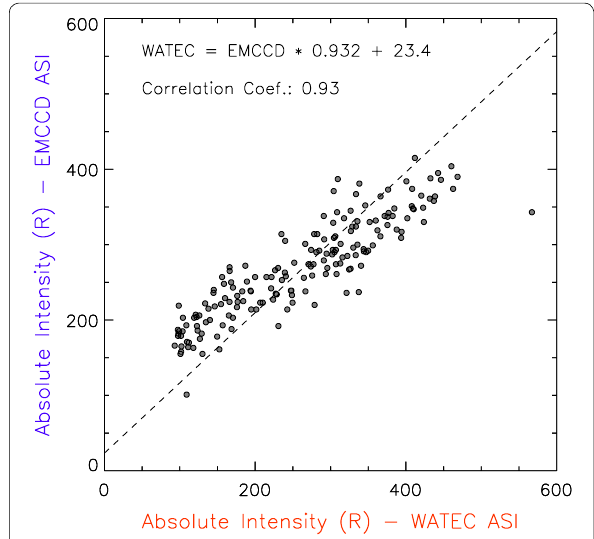
Fig. 5 Relationship between the absolute optical intensity values at zenith from the two ASI systems during the interval of polar cap patches shown in Fig. 4. Note that we only used data from 2010 to 2300 UT to remove the effect of large increase of emission intensity due to the appearance of aurora near the zenith in the first 10 min of the interval